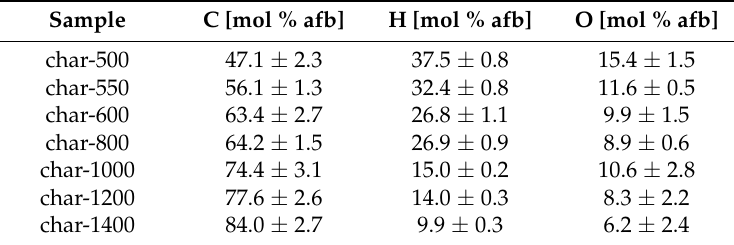
Table 3. C, H and O contents of the different